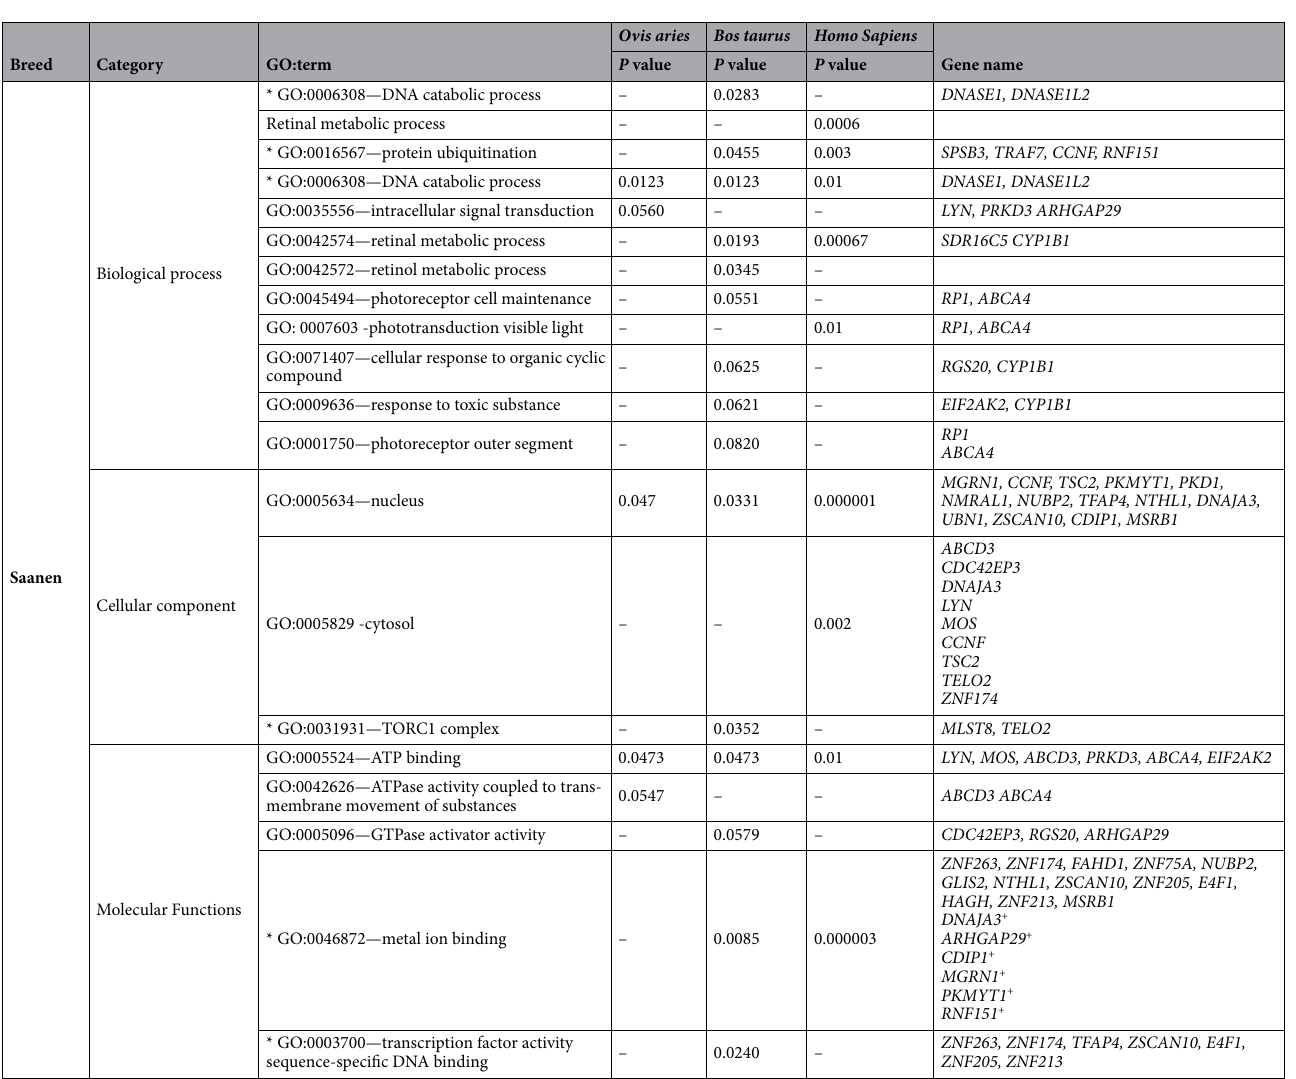
Table 4. Gene ontology terms significantly associated with biological processes, molecular functions, and cellular components for Angora, Boer, Nubian and Saanen breeds. *Genes from HapFLK analysis; + genes present only Homo sapiens annotation; In bold: genes present only in Bos Taurus